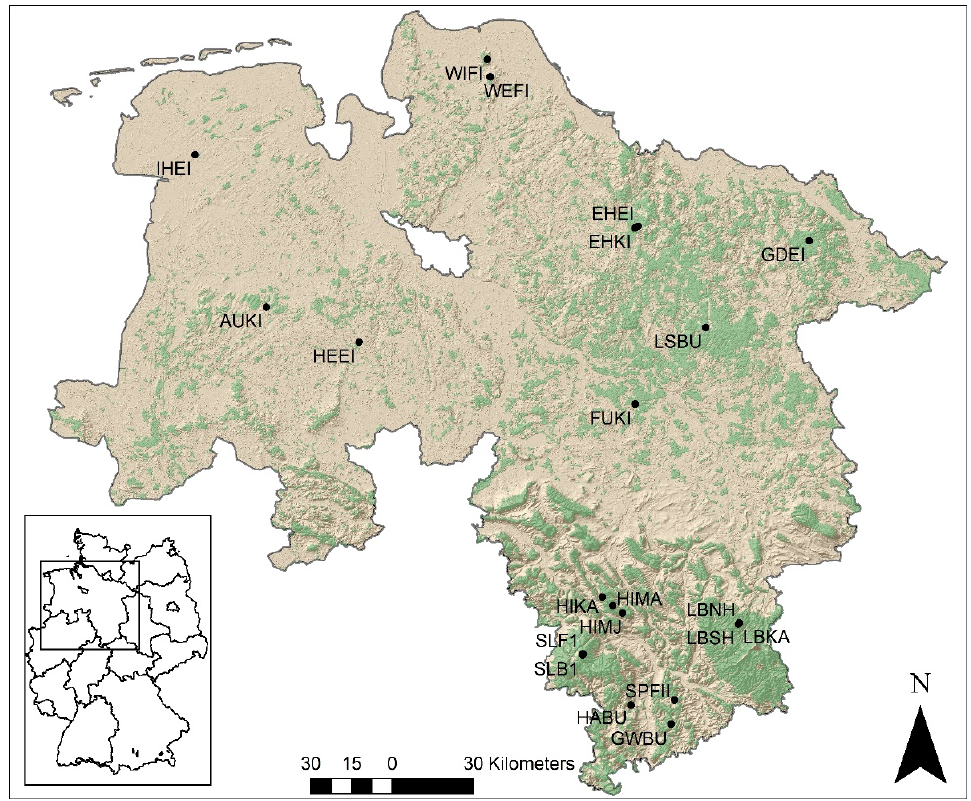
Figure 1. Location of 21 permanent soil-monitoring plots in Lower Saxony, Germany. The forested areas are represented with the color green. Abbreviations show the last four letters of the plot code (see Table 1).